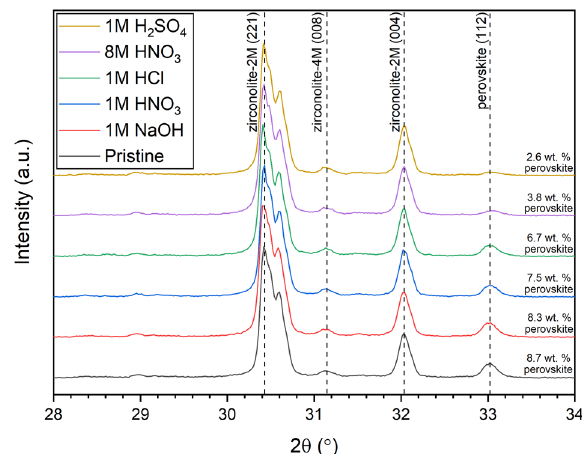
Fig. 6 Powder XRD data for CaZr 0.80 Ce 0.20 Ti 2.00 O 7 following leaching at 90 °C for 7 days. The remaining amount of perovskite, relative to the pristine sample, was determined by Rietveld analysis of powder diffraction data for recovered material.